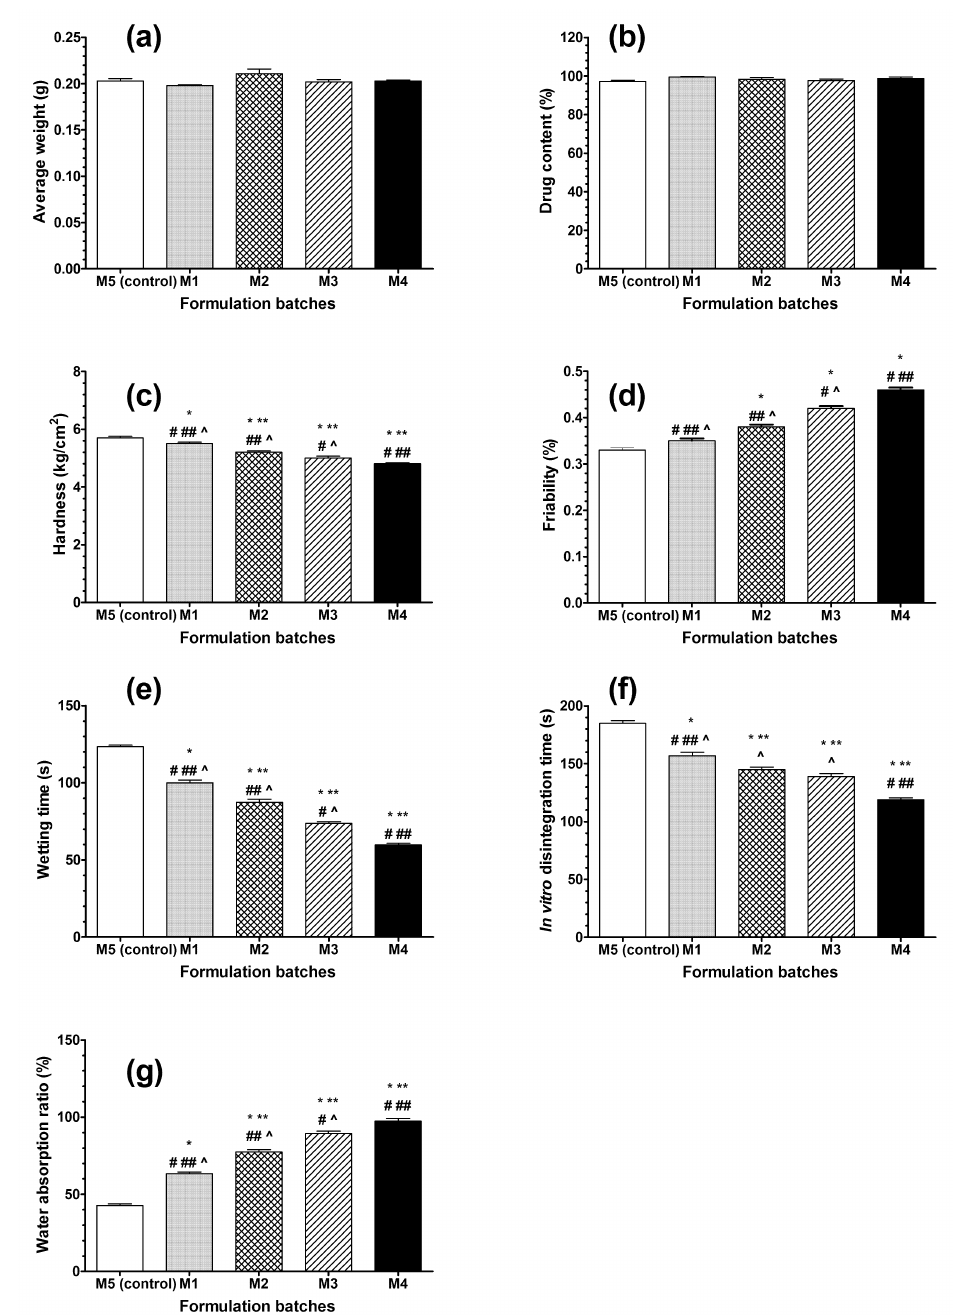
Figure 3. Post-compression parameters of orally disintegrating meloxicam tablets: ( a ) Average weight, ( b ) drug content, ( c ) hardness, ( d ) friability, ( e ) wetting time, ( f ) in vitro disintegration time, and ( g ) water absorption ratio. Data are presented as the mean ± SD, n = 5. The results were analyzed with one-way analysis of variance (ANOVA) followed by Tukey’s multiple comparison test. The batches were compared to the control and to each other. p < 0.05 showed a statistically significant di ff erence: * compared to control (M5), ** compared to M1, # compared to M2, ## compared to M3, ˆ compared to M4